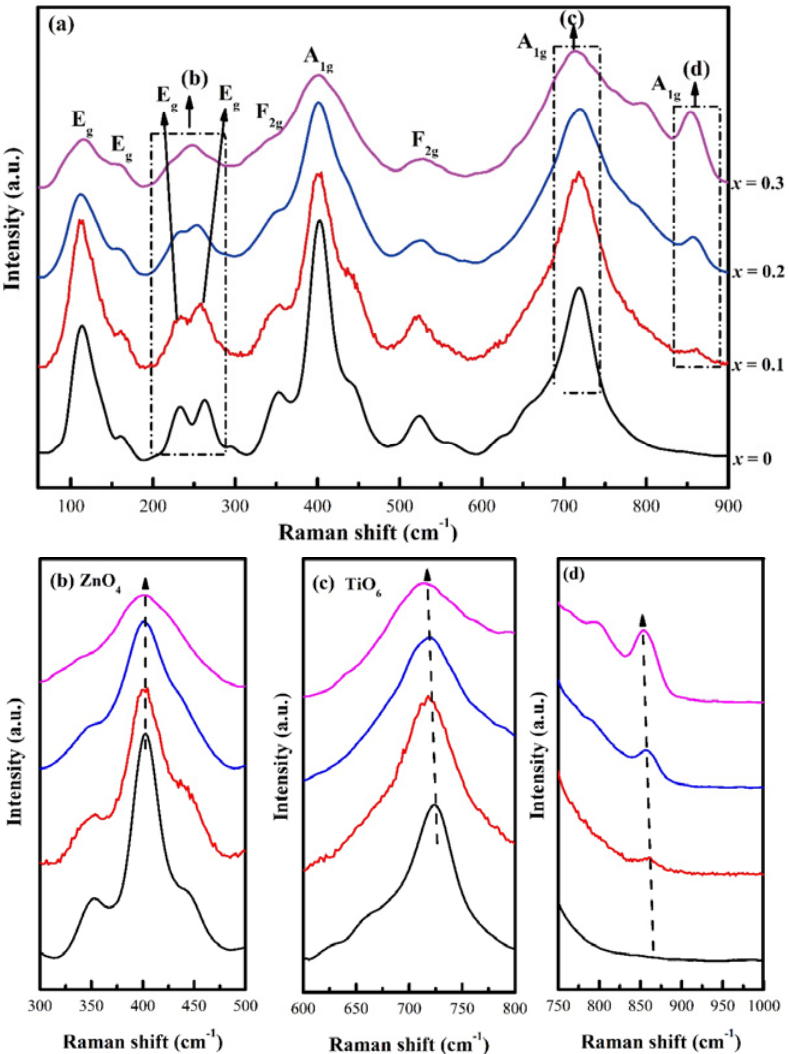
Fig. 5 (a) Raman spectra of LZTNN x ( x = 0–0.3) ceramics with different x values, (b) partially enlarged views of bands at 300–500 cm − 1 , (c) changing curves of mode at about 718 cm − 1 of Raman spectra, and (d) changing curves of mode at about 854 cm − 1 of Raman